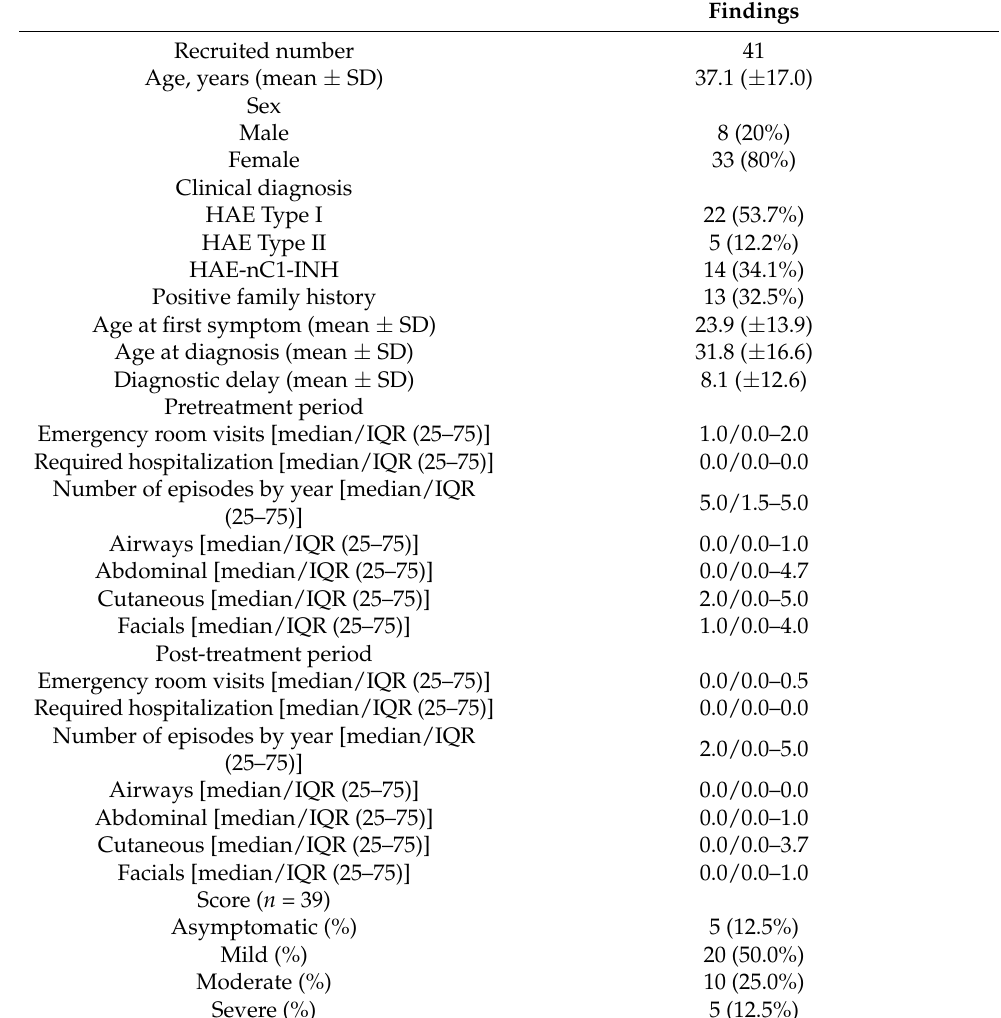
Table 1. Clinical features of the patients and healthy relatives recruited in this study.